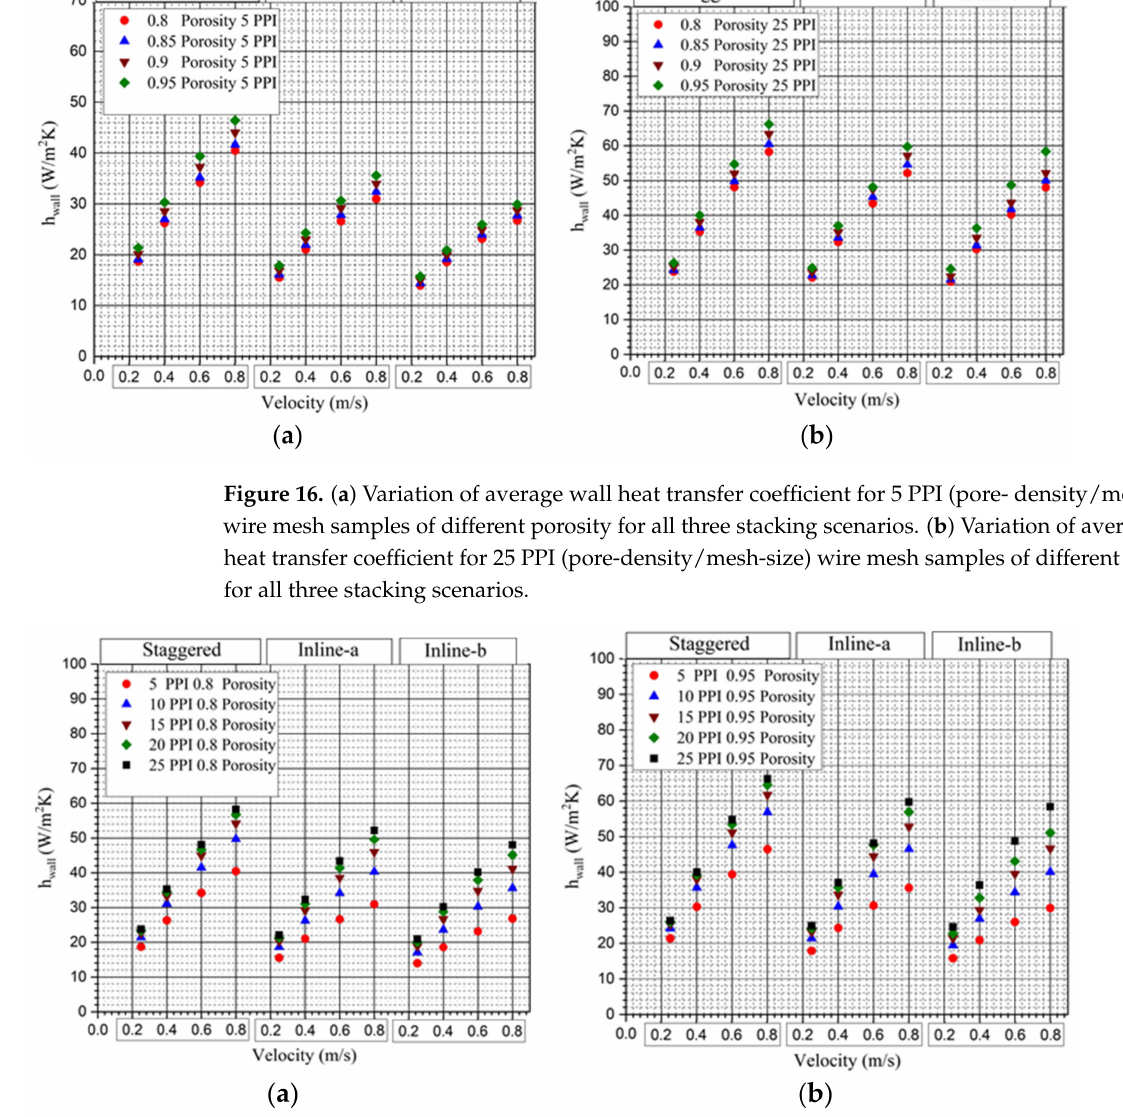
Figure 17. ( a ) Variation of average wall heat transfer coefficient for 0.8 porosity wire mesh samples of different pore-density/mesh-size for all three stacking scenarios. ( b ) Variation of average wall heat transfer coefficient for 0.95 porosity wire mesh samples of different pore-density/mesh-size for all three stacking